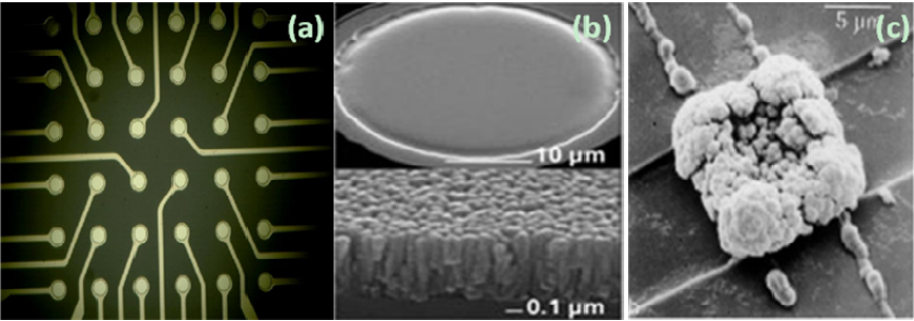
Figure 4. The surface morphology of microelectrodes with different treatment. ( a ) The chip layout of a 6 × 6 microelectrode array; ( b ) A microelectrode sputtered with T (http://www.multichannelsystems.com/); ( c ) A microelectrode electroplated with platinum black. (Reprinted from [38]. © 1980, with permission from